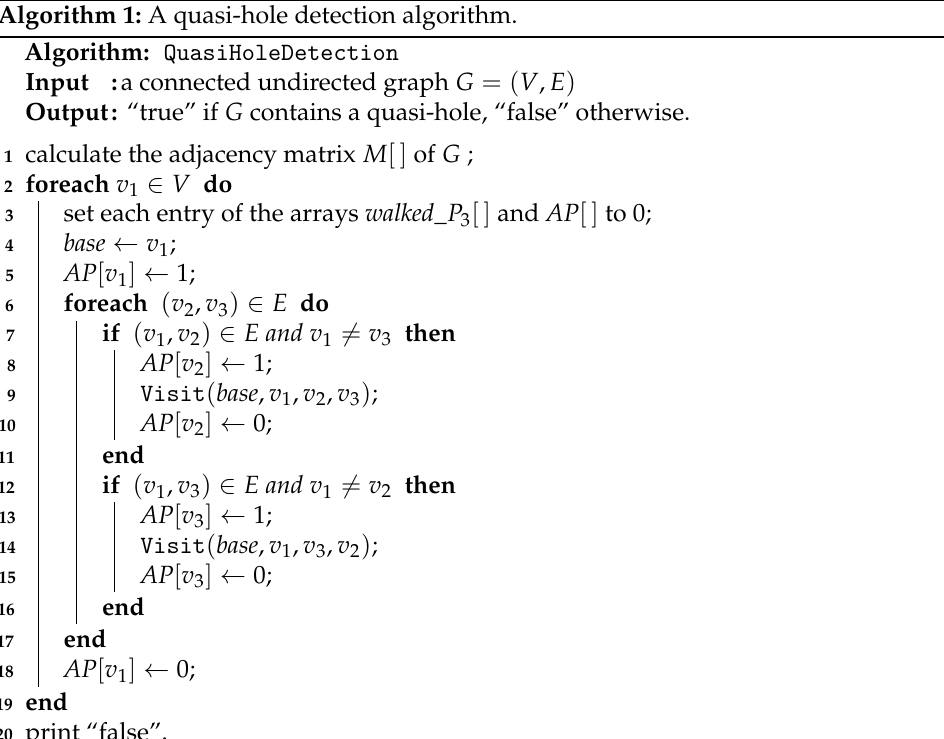
Algorithm 1: A quasi-hole detection algorithm. Algorithm: